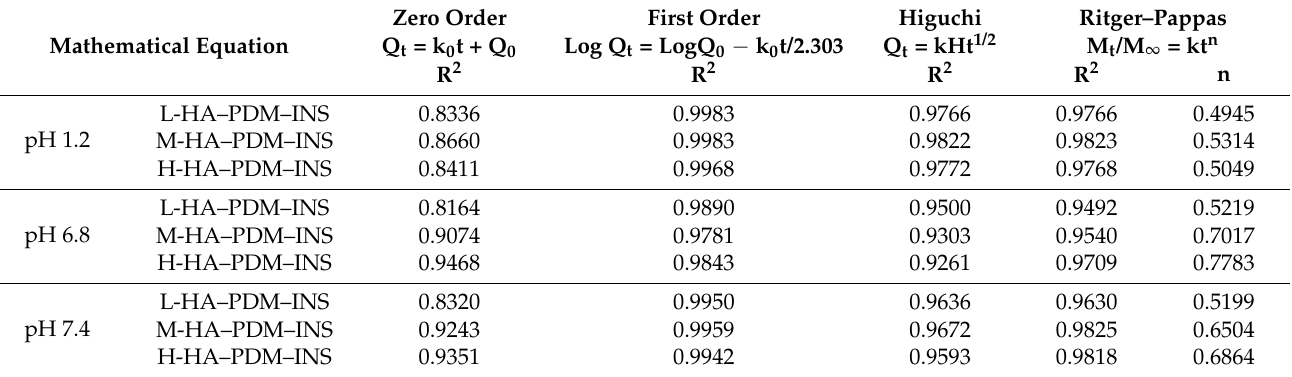
Figure 5. In vitro release profile of insulin from HA–PDM–INS in pH 1.2 ( A ), pH 6.8 ( B ), and pH 7.4 ( C ) PBS (X ± SD, n = 6, * p < 0.05, ** p < 0.01, *** p < 0.001). ( D ) Circular dichroism spectra of insulin released from three nanoparticles. Table 4. Mathematical models of the regression for in vitro release profiles of